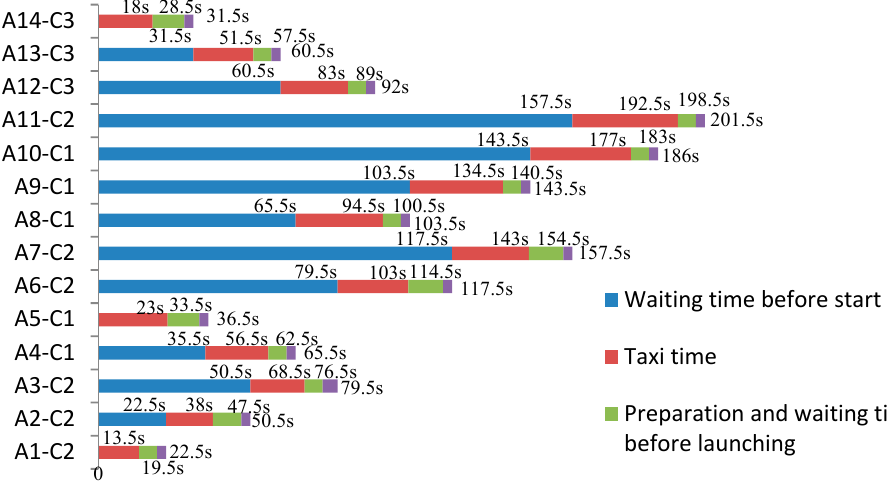
Figure 15. The time histories of each aircraft.